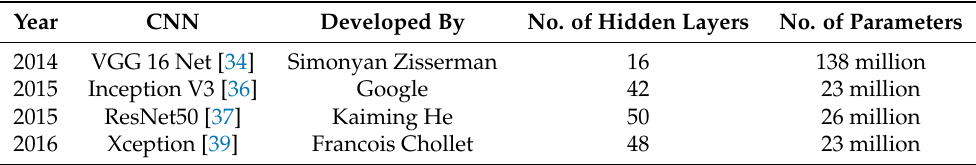
Table 1. Comparison of the four network architectures